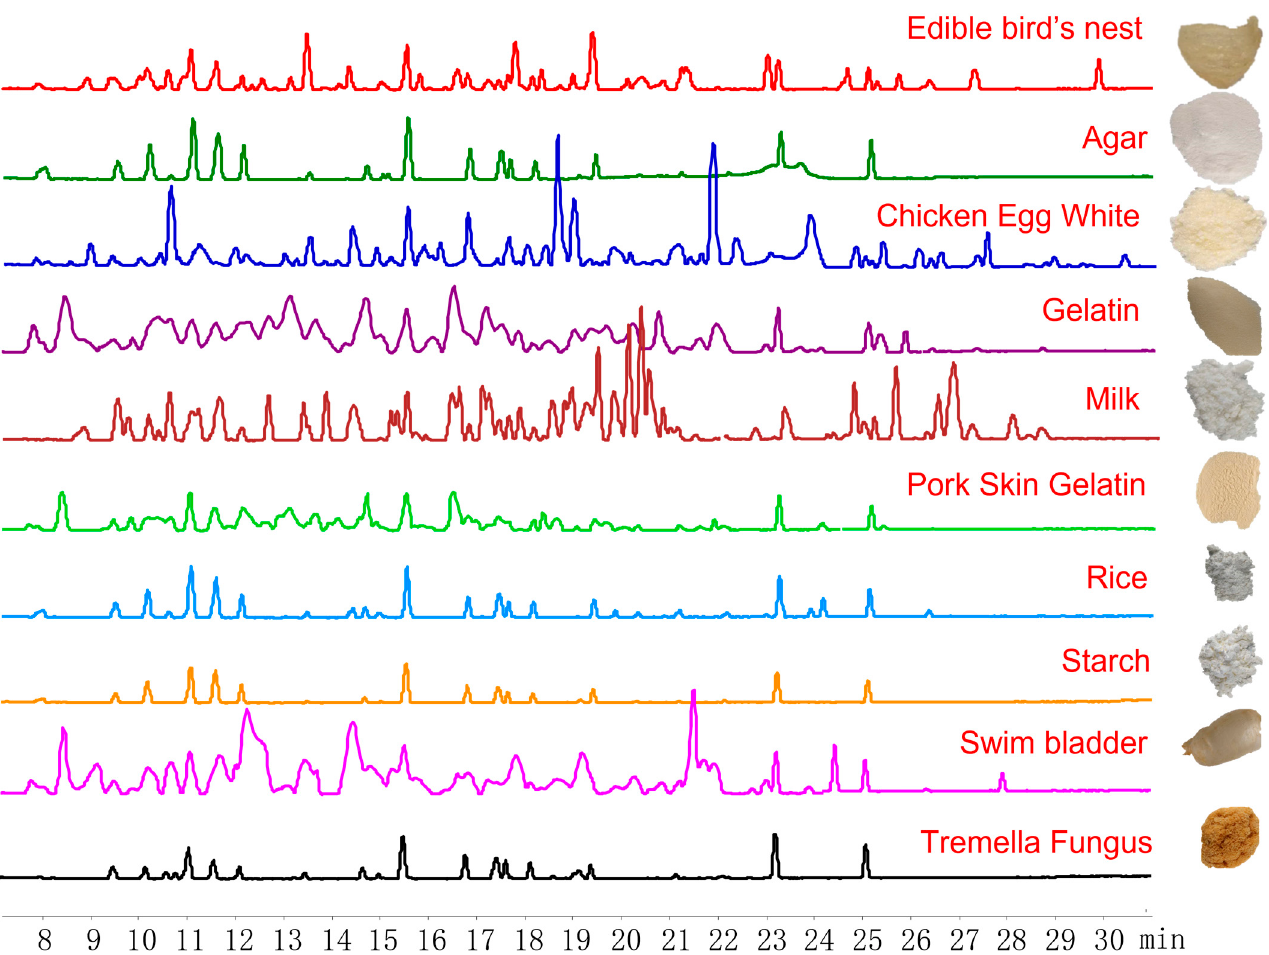
Figure 1. Base peak chromatograms ( left ) and typical morphology ( right ) of Edible bird’s nest and related adulterants.